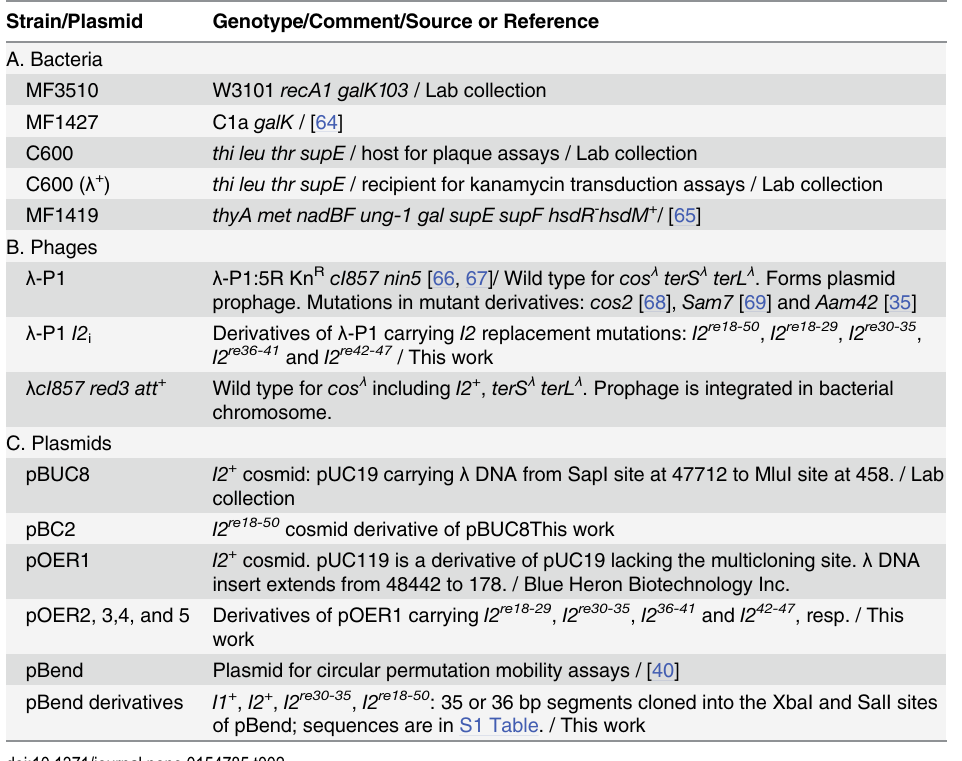
Table 2. Bacteria, Phages, and